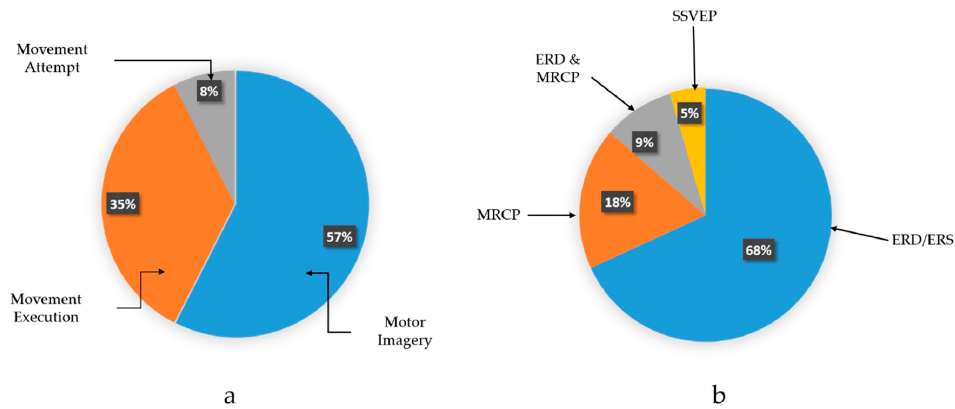
Figure 5. ( a ) Percentage of movement’s tasks and ( b ) Percentage of EEG signal type utilized in the selected studies.